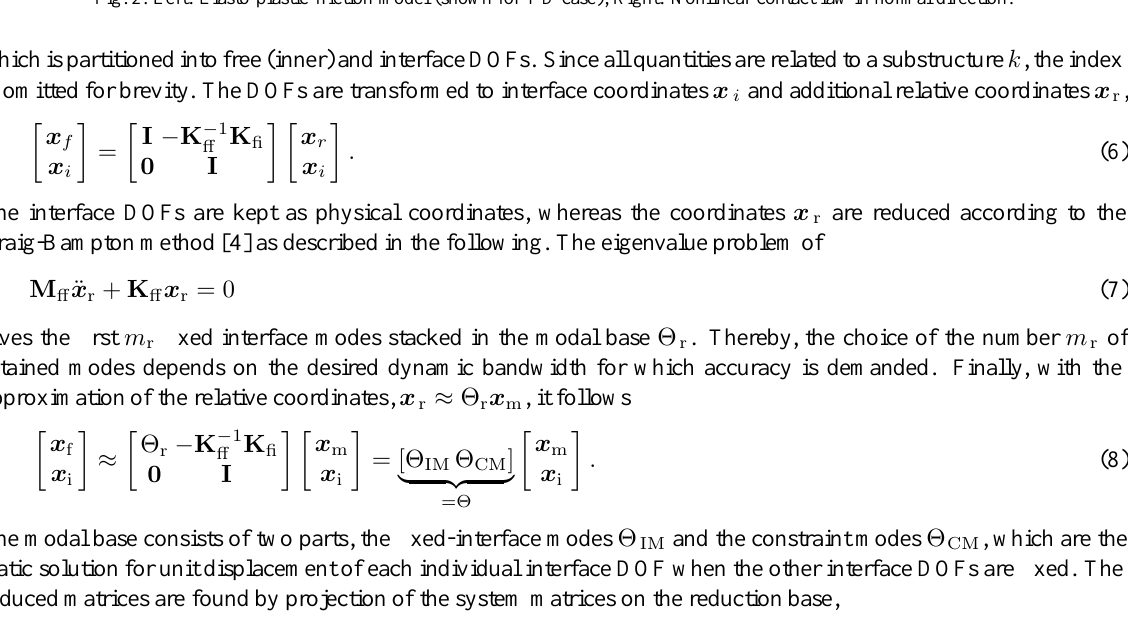
Fig. 2. Left: Elasto-plastic friction model (shown for 1-D case); Right: Nonlinear contact law in normal